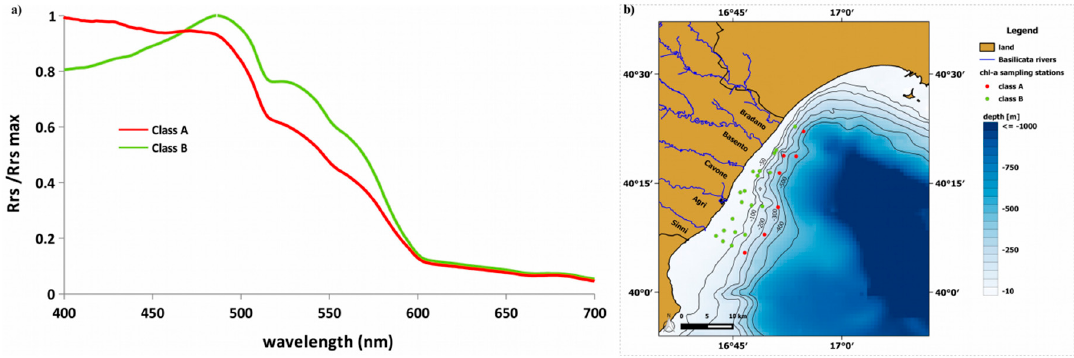
Figure 7. ( a ) The normalized average spectral shapes (R rs ( λ )/max(R rs ( λ )) for the classes A and B. ( b ) Locations of the analysed stations falling within the classes A (red dots) and B (green dots). The continuous lines are bathymetry depths ranging from 50 to 500 m depth.